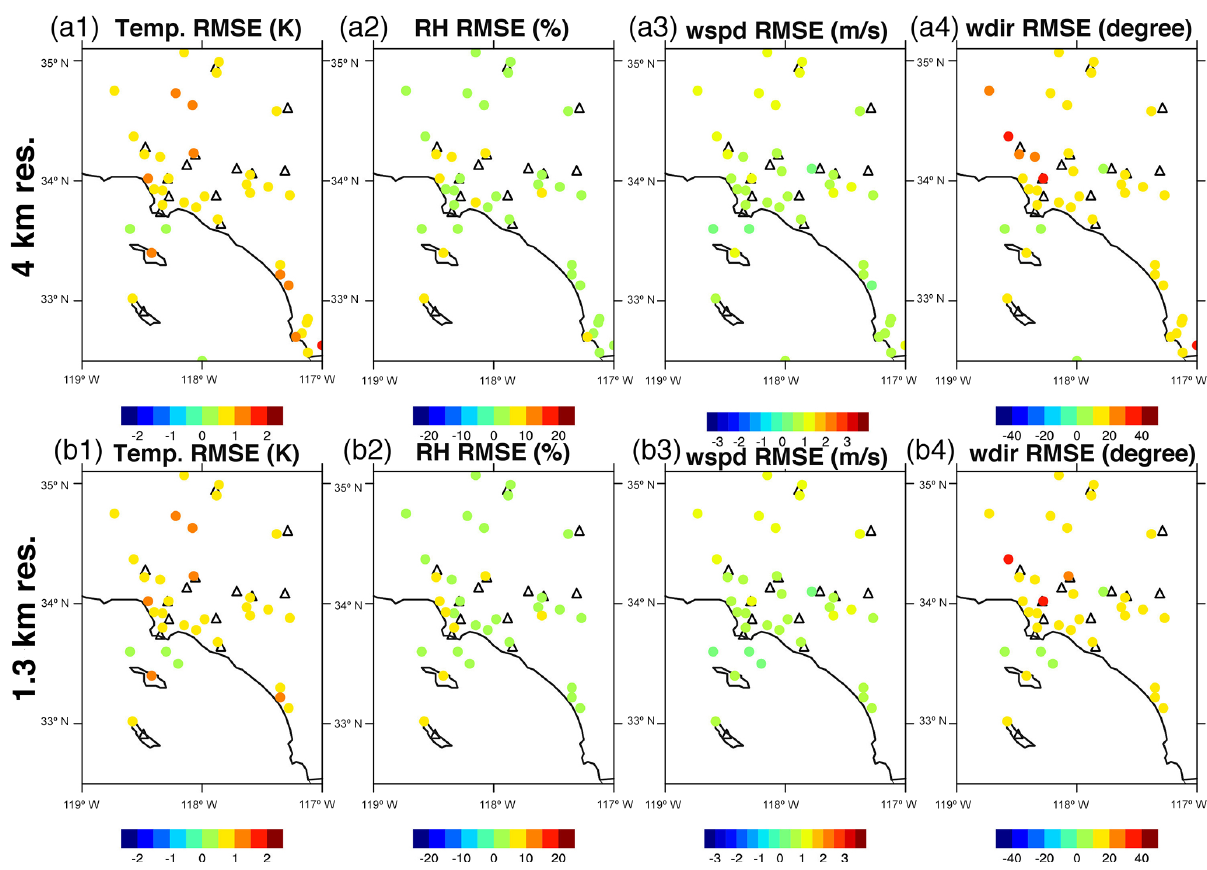
Figure 7. RMSE maps of atmospheric state variables from the MYNN_UCM runs versus National Weather Stations (NWS) over the LA megacity: (a1–a4) 4km run; (b1–b4) 1.3km run. Black triangles indicate the locations of the GHG measurement sites. Note daytime 11:00– 17:00PST